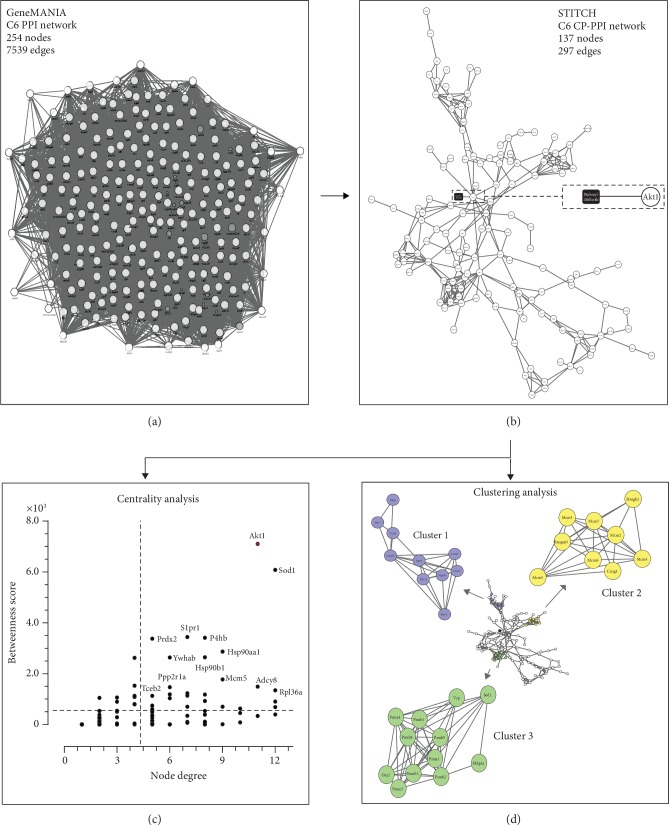
(a) C6 PPI network obtained from GeneMANIA software and cell line microarray data analysis. (b) C6 CP-PPI network showing interactions between DPDT and specific targets. (c) Network centrality analysis to define H-B nodes from the CP-PPI network. DPDT's H-B target appears in red. (d) Clustering analysis from the C6 CP-PPI network using ClusterONE [84, 85].